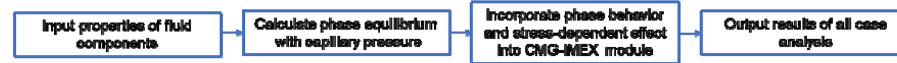
Figure 1. The flow chart of well performances in tight oil reservoirs.